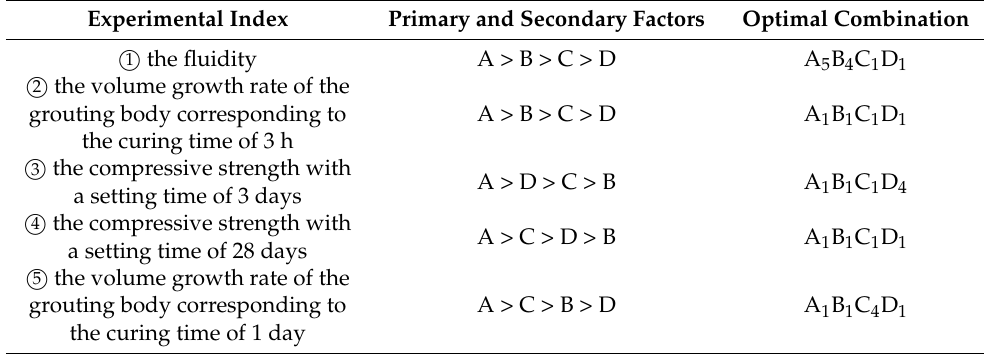
Table 7. The influence of four factors on each experimental index in descending order and the optimal